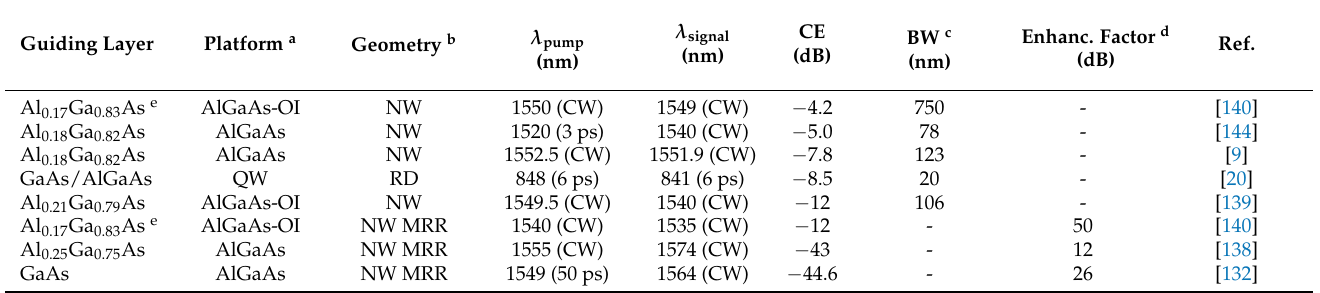
Table 7. Conversion efficiencies (CE) reported for FWM in AlGaAs waveguides (WG) and microring resonators